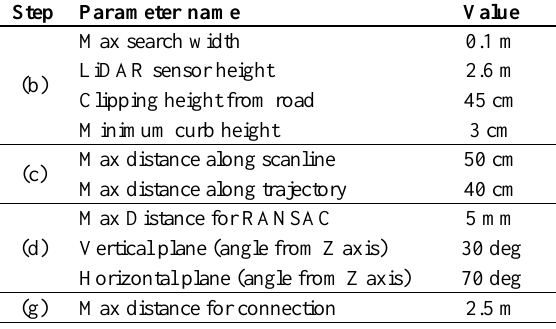
Table 1. Parameter values